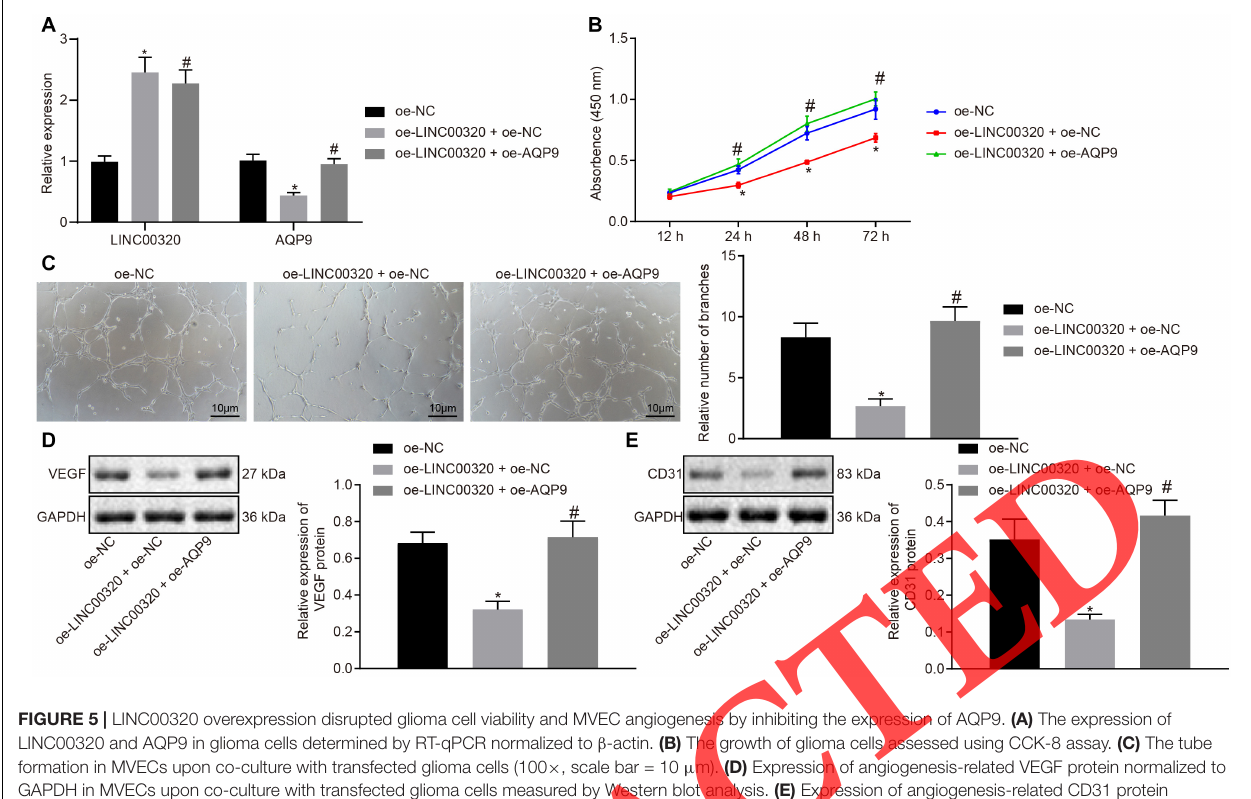
FIGURE 5 | LINC00320 overexpression disrupted glioma cell viability and MVEC angiogenesis by inhibiting the expression of AQP9. (A) The expression of LINC00320 and AQP9 in glioma cells determined by RT-qPCR normalized to β -actin. (B) The growth of glioma cells assessed using CCK-8 assay. (C) The tube formation in MVECs upon co-culture with transfected glioma cells (100 × , scale bar = 10 µ m). (D) Expression of angiogenesis-related VEGF protein normalized to GAPDH in MVECs upon co-culture with transfected glioma cells measured by Western blot analysis. (E) Expression of angiogenesis-related CD31 protein normalized to GAPDH in MVECs upon co-culture with transfected glioma cells measured by Western blot analysis. * p < 0.05 vs. cells transfected with oe-NC, # p < 0.05 vs. cells co-transfected with oe-LINC00320 and oe-NC. Data were expressed as mean ± standard deviation, and comparisons among multiple groups were conducted by one-way ANOVA, followed by a Tukey multiple-comparisons posttest. The experiment was repeated three times